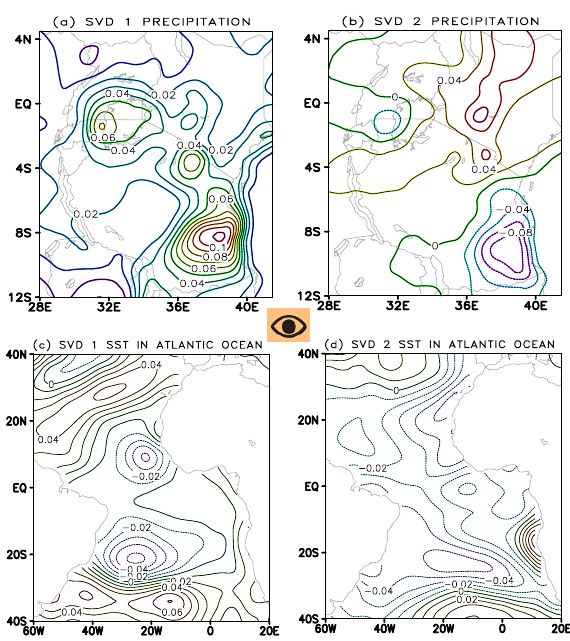
Figure 2. The homogeneous map of the first two modes of SVD for the Precipitation (mm/month) (a and b) and SST ( ° C) in an Atlantic Ocean (c and